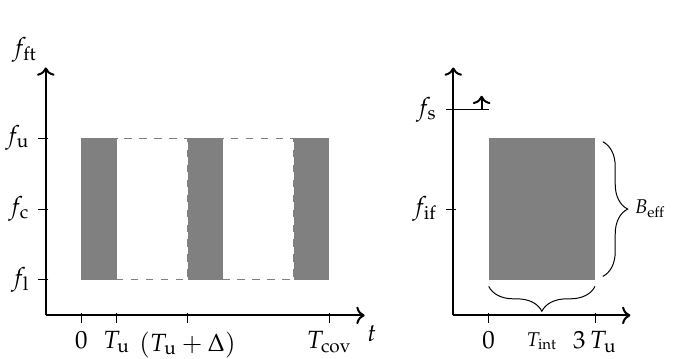
Figure 1. Spectrogram of an emitted pulsed waveform with its T - B characteristics, RF carrier f c , lower f l , upper f u , baseband intermediate f if and quadrature sampling frequency f s